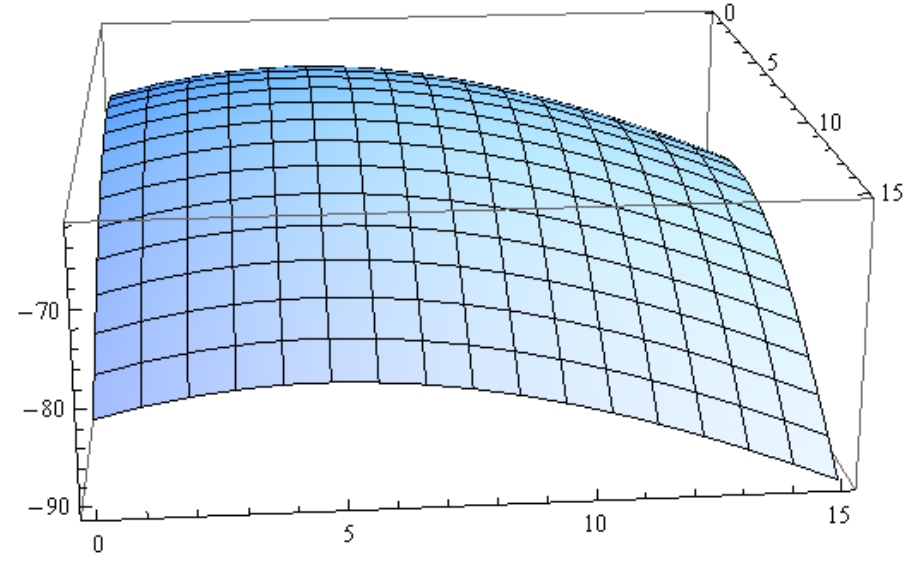
Figure 1. Profile log-likelihood function ( y -axis) of ( β 1 , x -axis) and ( β 2 , z -axis).